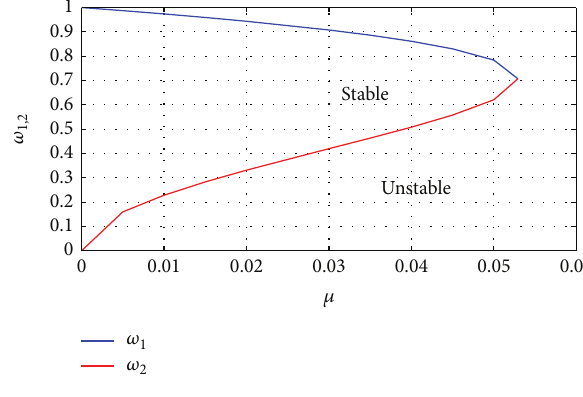
Figure 11: Correlation between 𝜇 and 𝜔 1,2